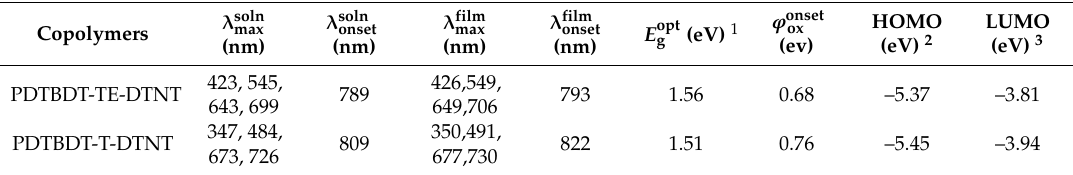
Figure 1. Normalized UV-Vis spectra of PDTBDT-TE-DTNT in dilute chlorobenzene solution and solid thin film. Table 1. Optoelectronic parameters of the copolymers.